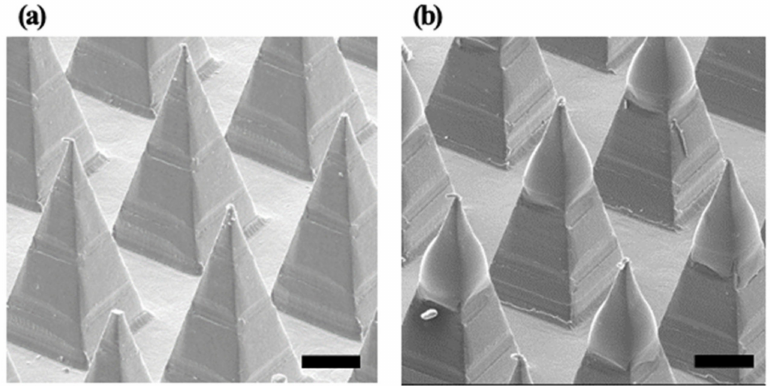
Figure 1. Images of ( a ) uncoated polylactic acid (PLA) microneedles and ( b ) coated microneedles with hepatitis B virus (HBV) surface antigen (HBsAg) formulation. Scale bar is 200 µ